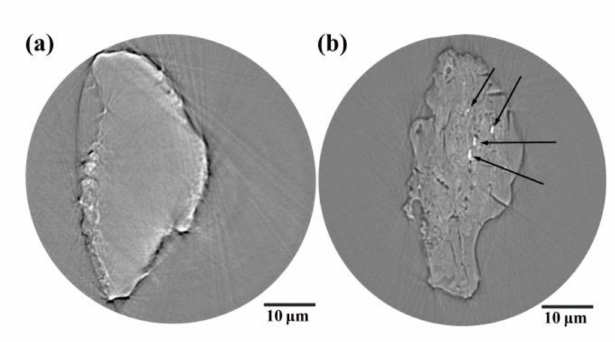
Figure 10. The typical slice of 3 h ball milling powders ( a ) Mg, ( b ) Mg-6%CoCl 2